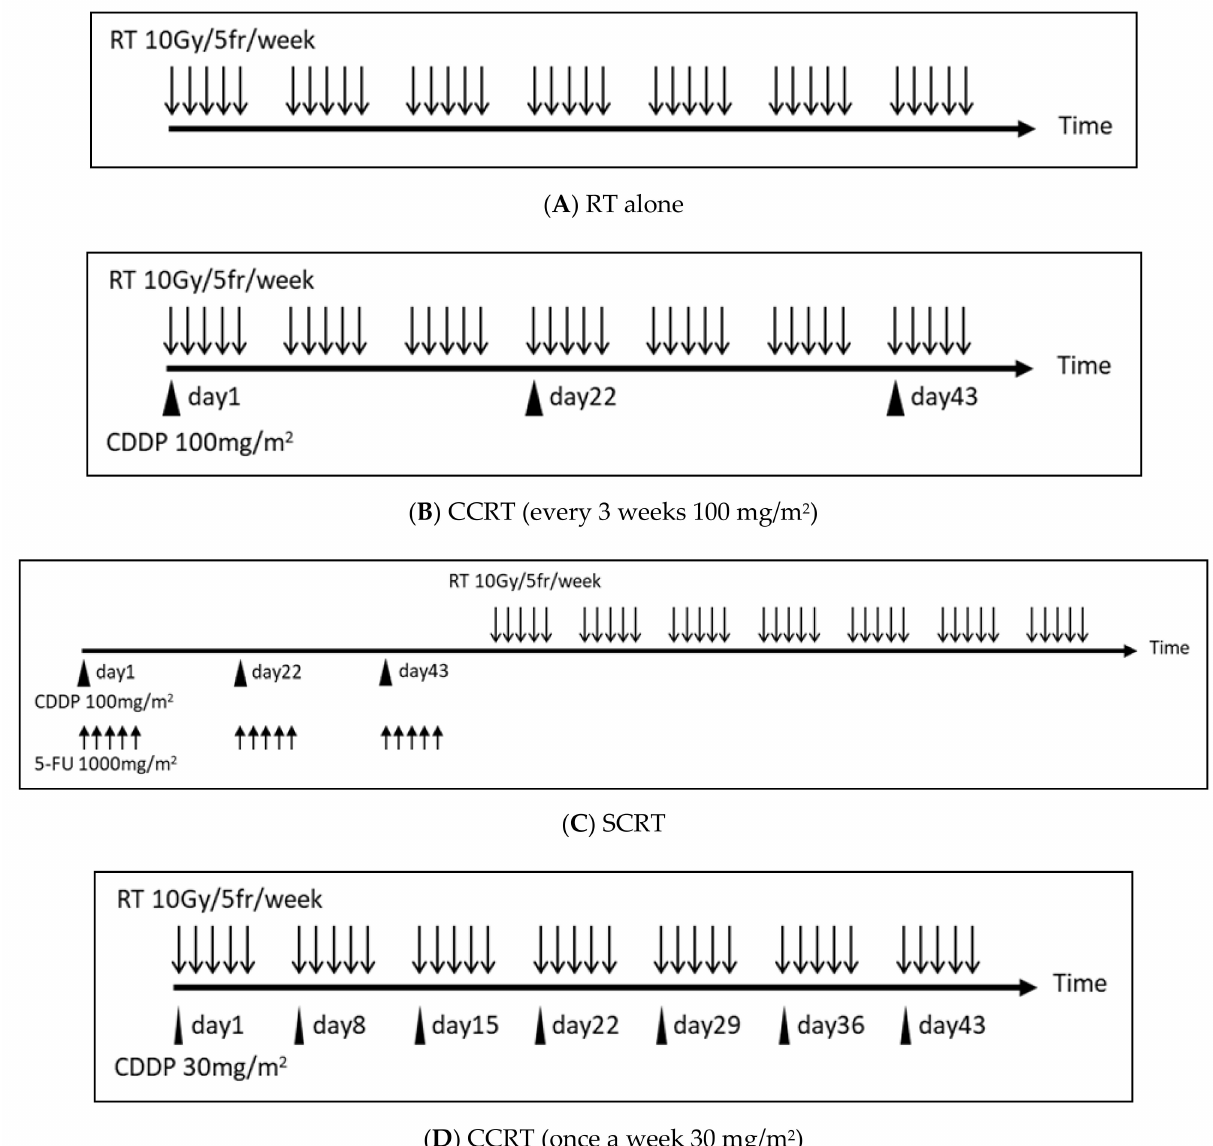
Figure 4. The protocol regimens of each arm of three clinical trials of RT plus CDDP for head and neck cancer. ( A ) Do 2 Gy per 1 fr, 5 times a week. Continue this for 7 weeks. ( B ) Administer CDDP every 3 weeks (day 1, day 22, day 43) within a few hours before or after RT. The CDDP administration is 100 mg/m 2 per dose. ( C ) Initially, administer 5-FU for 5 consecutive days + simultaneous CDDP every 3 weeks (the addition of 5-FU increases the intensity of chemotherapy). Perform RT sequentially. The CDDP dose is 100 mg/m 2 per dose, the 5-FU dose is 1000 mg/m 2 per dose. ( D ) Administer a small quantity of CDDP once a week within a few hours before or after RT. The CDDP dose is 30 mg/m 2 per dose. Abbreviations: RT, radiotherapy; fr, fraction; CCRT, concurrent chemo-radiotherapy; SCRT, sequential chemo-radiotherapy; Gy, gray; mg, milligram; m 2 , square